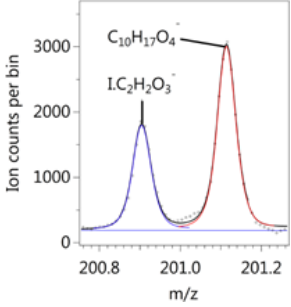
Figure 2. Example of peak separation between an iodide adduct I.C 2 H 2 O − and deprotonated signal C 10 H 17 O − 3 background measurements before the low-NO x